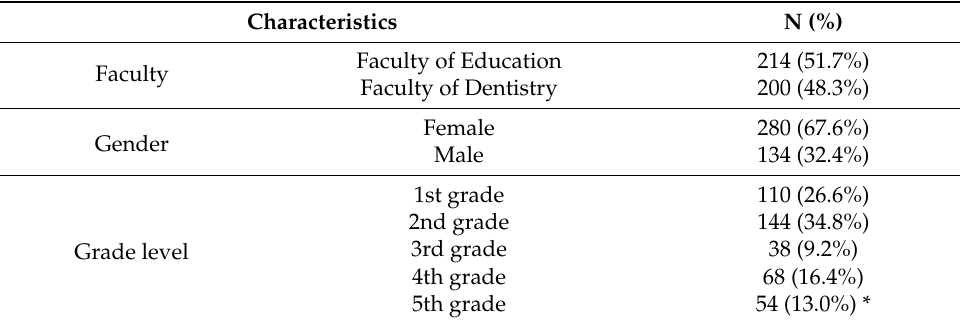
Table 1. Demographic characteristics of the sample